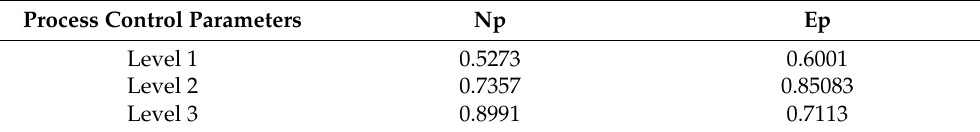
Table 6. Effects of process control parameters on process performance for argon-rich atmosphere. Process Control